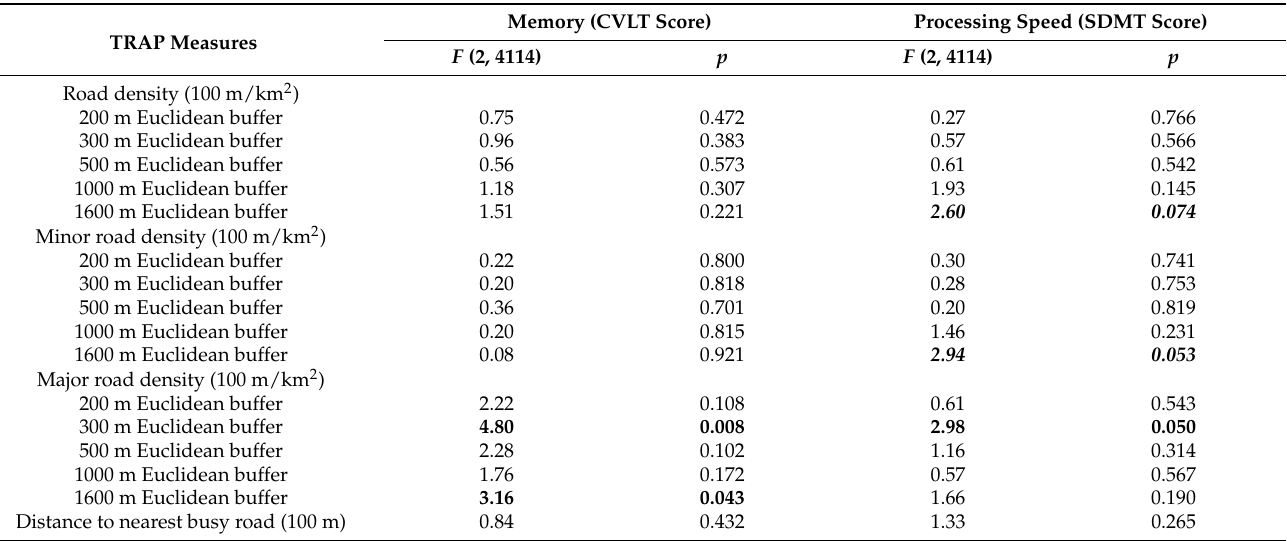
Table 4. Moderation effects of diabetes status on the associations between traffic-related air pollution measures with cognitive function (multiple imputation analyses; n =